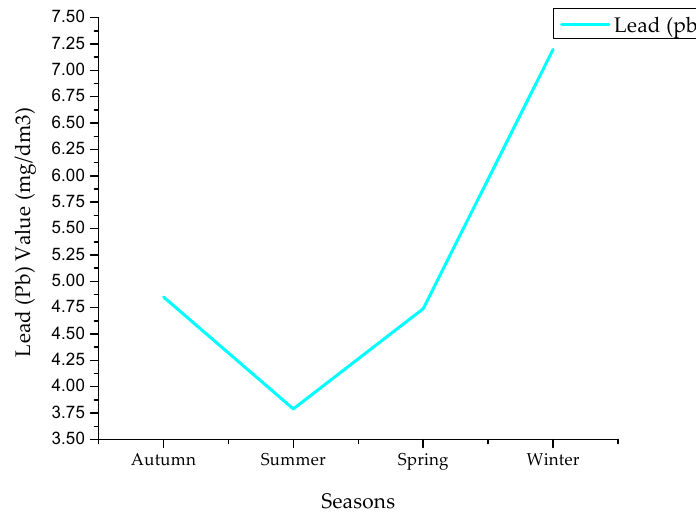
Figure 10. Concentration values for (Pb) from image during four seasons in 2017.